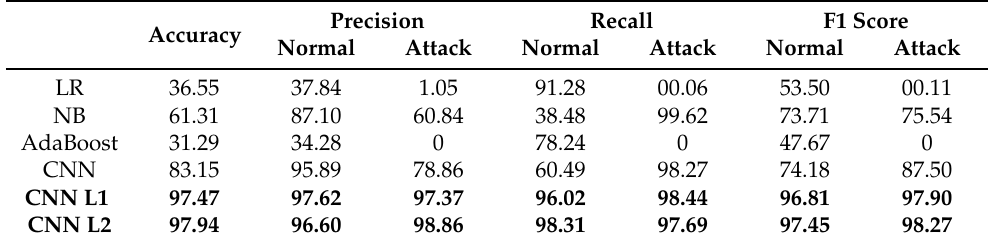
Table 9. The percentage results of Scenario A.